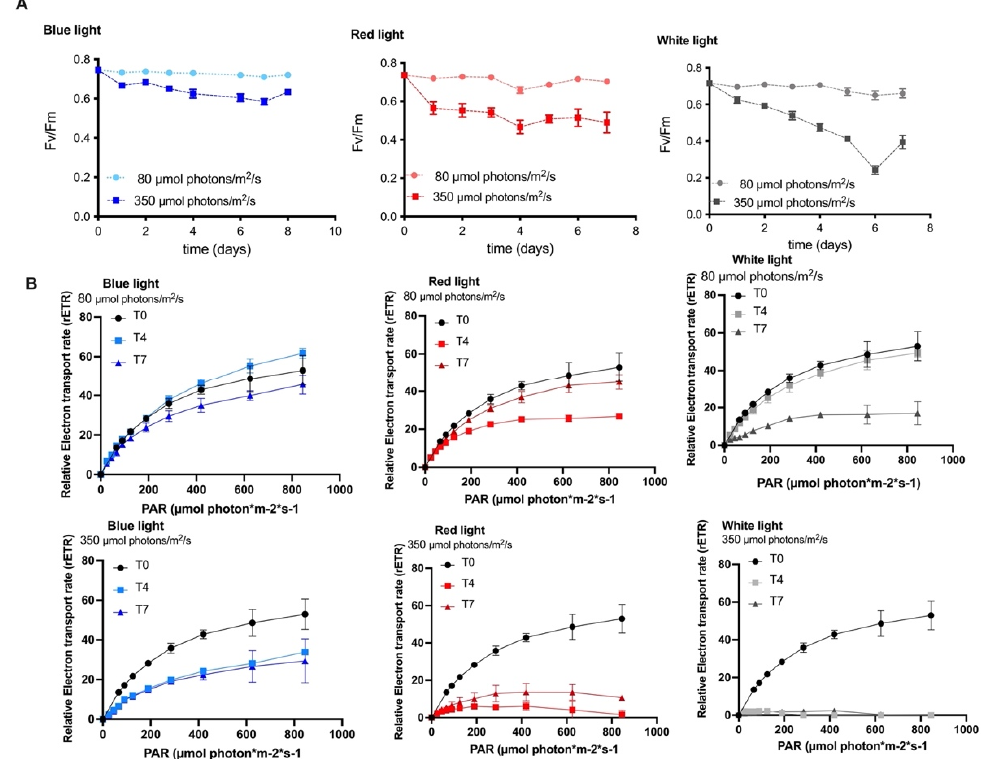
Figure 2. ( A ) Effective quantum yields of PSII [Y (II)] of the MCH-35 microalgae grown under dif- ferent light wavelengths (red, blue, and white) and irradiances (80 µmol photons/m 2 /s and 350 µmol photons/m 2 /s). ( B ) Relative electron transport rates (ETR) observed on days 0, 4, and 7 of the MCH- 35 microalgae grown under different light wavelengths ( red, blue, and white) and irradiances (80 µmol photons/m 2 /s and 350 µmol photons/m 2 /s). Data are expressed as the mean ± SD ( n = 4).